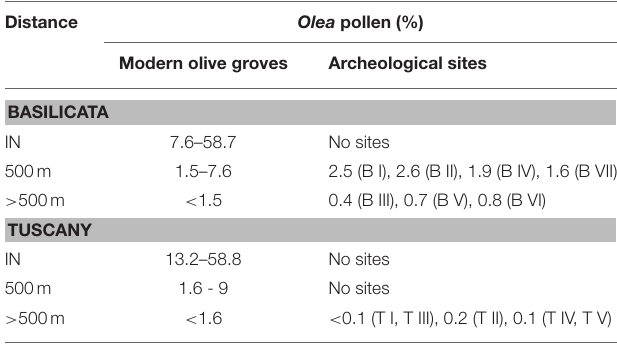
TABLE 3 | Percentage of Olea pollen from the archeological sites of Basilicata and Tuscany, in relation to the distance from the center of an olive grove. Distance Modern olive